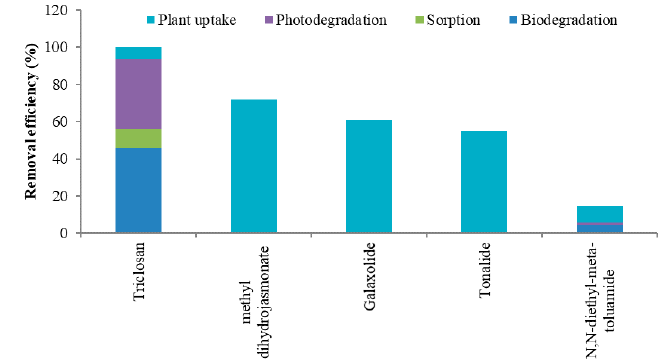
Figure 3. Relative contribution of removal mechanisms for PCPs in hydroponic microcosms, media adsorption experiments, and CWs. Note: Adsorption is the adhesion of dissolved solid molecules (adsorbate) to a surface of the substrate (adsorbent). It is a surface phenomenon. Absorption is a process in which a fluid (absorbate) permeates a solid (absor-